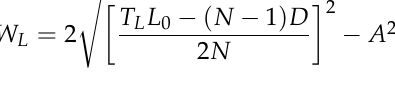
Figure 30. Different models used to describe the interfacial roughness profile: ( a ) continuous roughness model, ( b ) transitional roughness model, ( c ) generalized roughness model.